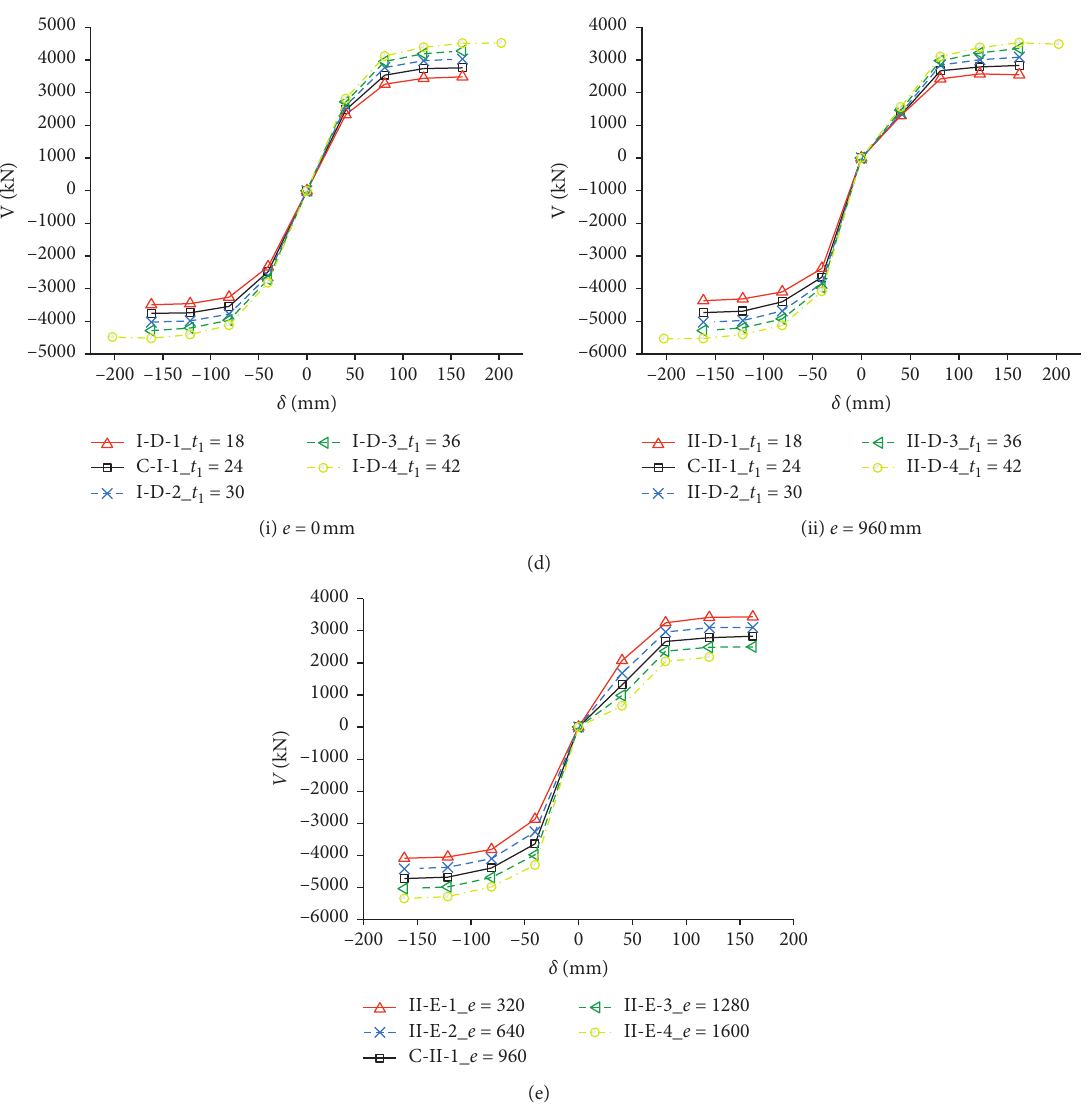
Figure 18: Skeleton curves of numerical specimens. (a) Effects of axial compression ratio ( n ). (b) Effects of strength of energy dissipation wall plate ( f 1 ). (c) Effects of spacing between horizontal stiffening ribs ( DS 1 ). (d) Effects of thickness of energy dissipation wall plate ( t 1 ). (e) Effects of eccentricity ( e